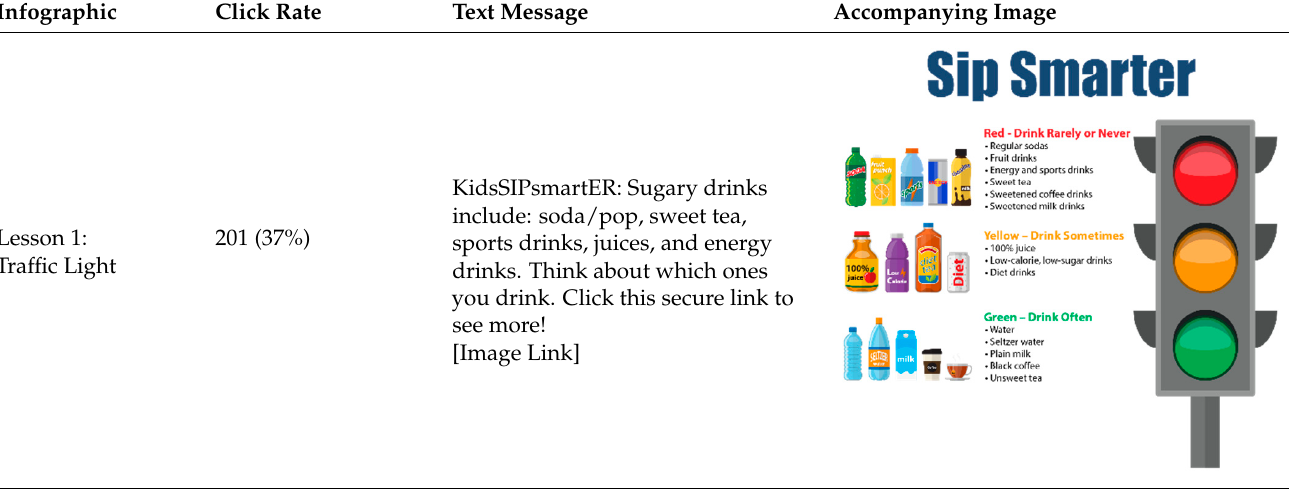
Accompanying Accompanying Image